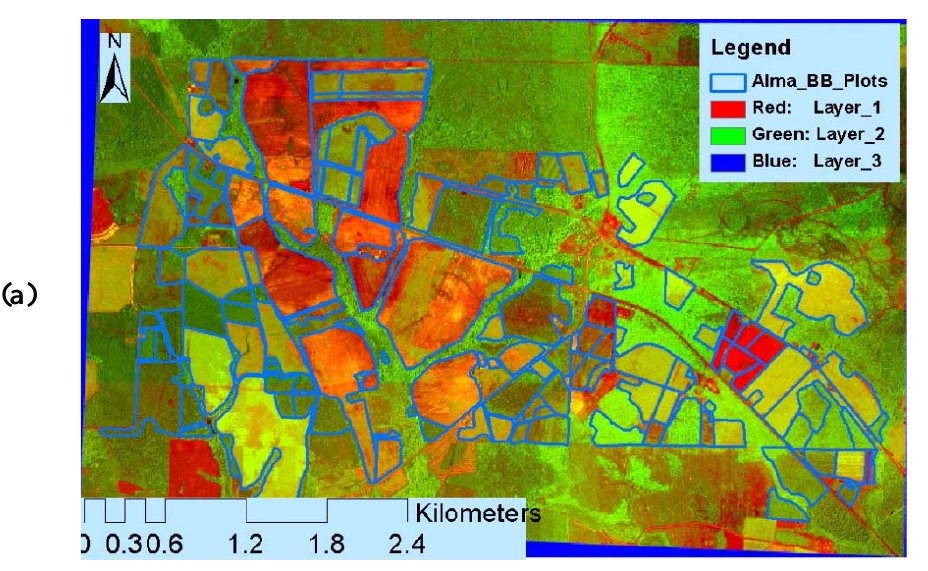
Figure 2. Principal component image of the three study areas in Georgia, U.S: Bacon (a) , Brantley (b) , and Camden County (c), along with the GPS recorded blueberry farms at different